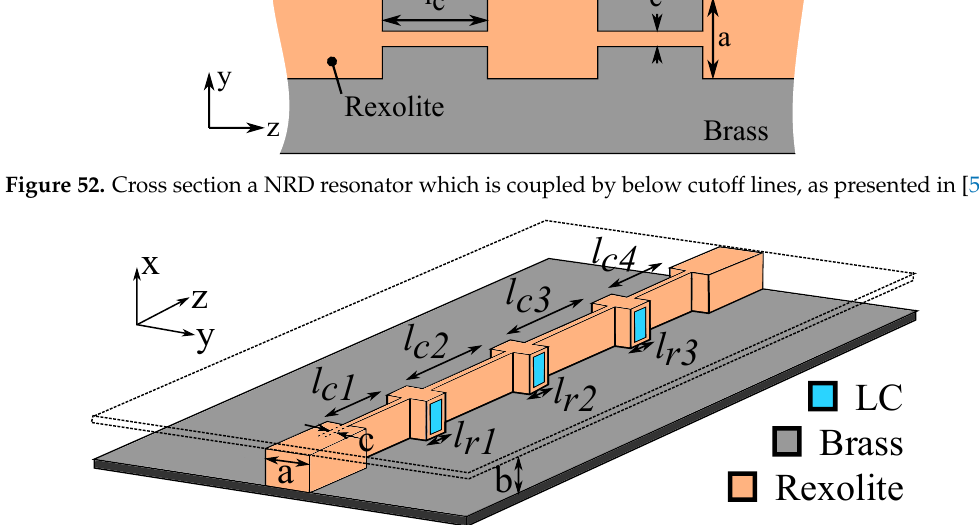
Figure 53. Cross section a 3-pole tunable filter with three NRD resonators coupled by below-cutoff lines, as presented in [50].